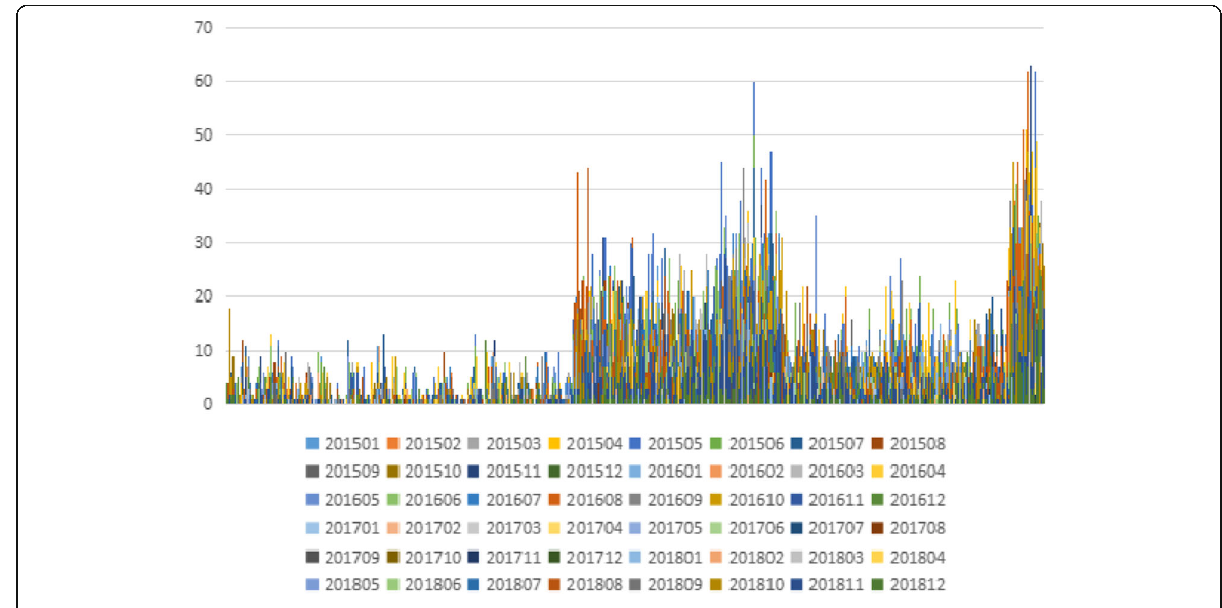
Fig. 2 Monthly cases of each traffic police brigade from 2015 to